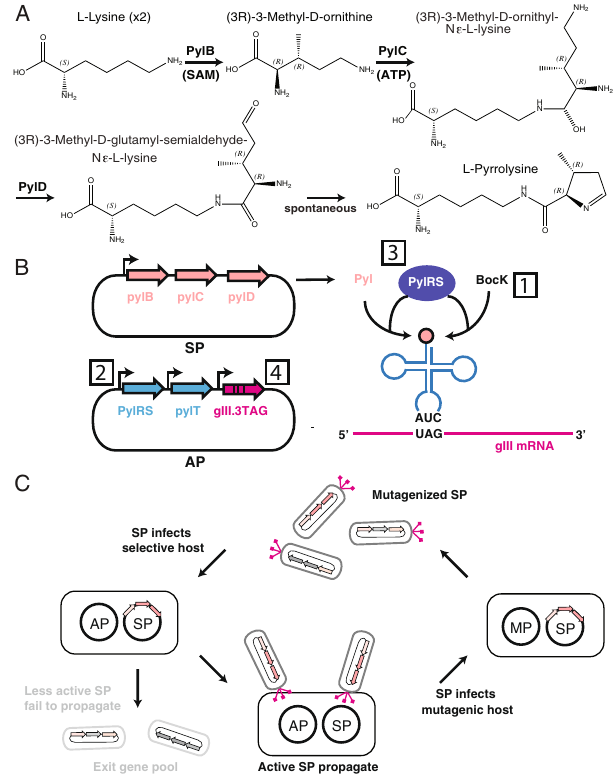
Fig. 1 Pyl biosynthetic pathway evolution via Alt-PANCE. A Pyl biosynthesis involves condensation of two lysine molecules by three enzymes — the radical SAM enzyme PylB, ATP-dependent PylC, and PylD. B Biosynthetic pylBCD operon was cloned into a selection phage (SP), while the constitutively expressed pylST and phage shock promoter-controlled gIII were cloned into accessory plasmid (AP) vectors. Numbered portions indicate selection circuit elements that were altered throughout evolution to control selection stringency, including (1) supplementation with BocK, (2) expression level of PylRS, (3) mutant variants of PylRS used, and (4) the number of amber codons present in gIII . C Each Alt-PANCE round entailed two phage passages: selective passage (left) entails operon activity- dependent expression of PIII (pink rods with circular tips); mutagenic passage (right) entails mutagenesis plasmid (MP)-dependent mutagenesis of the